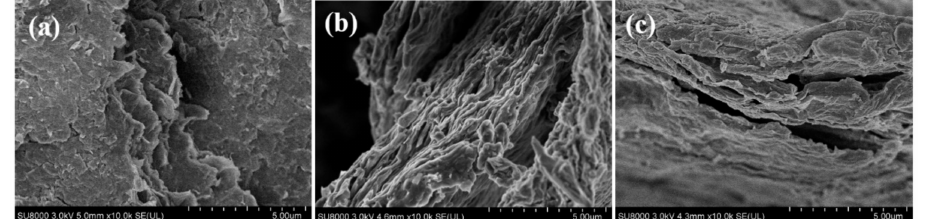
Figure 1. Scanning electron microscopy (SEM) micrographs of GO and the GO-based sorbents: ( a ) GO, ( b ) GO–CTS, and ( c ) GO–Al.